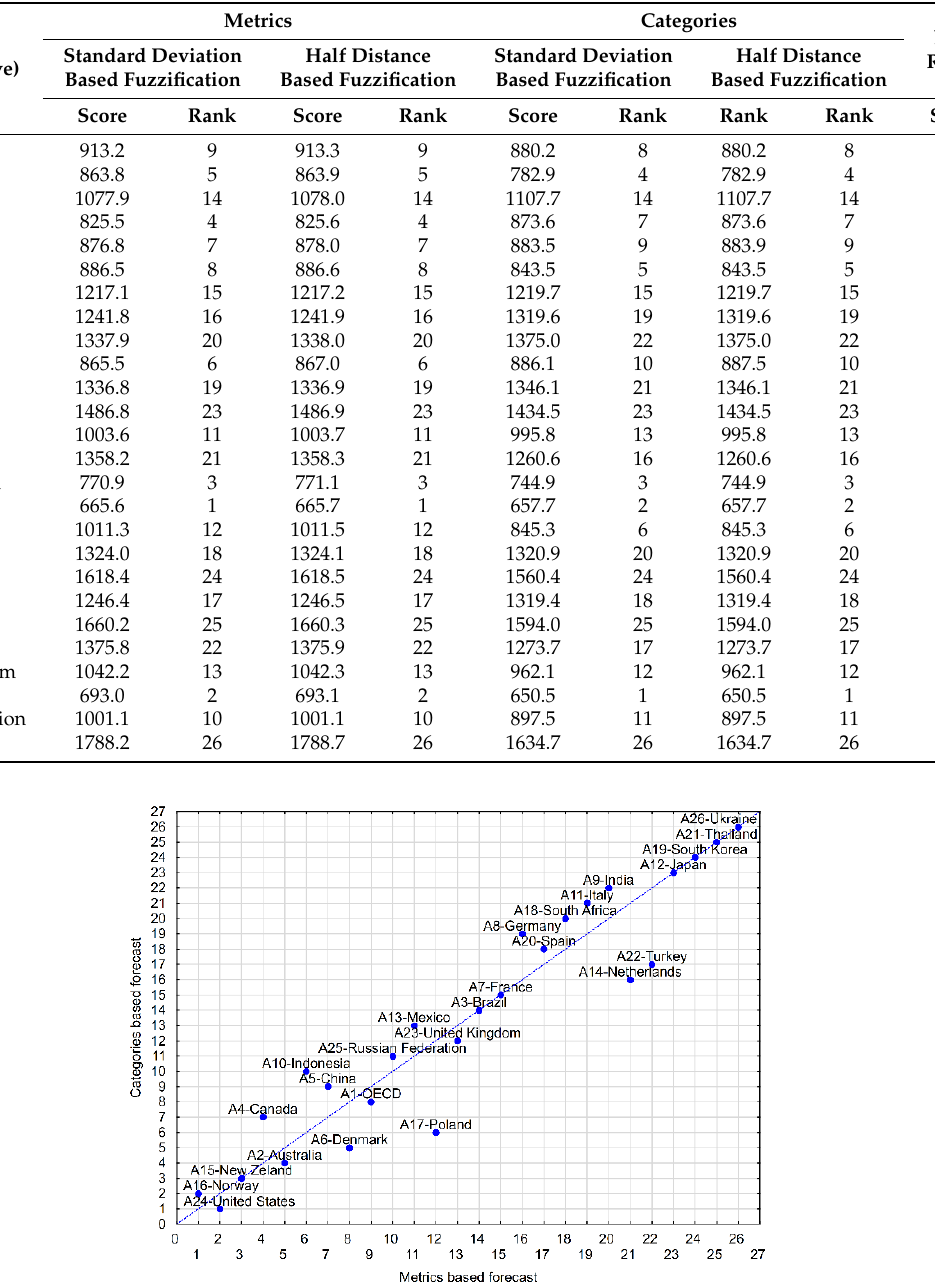
Table 5. IESRI rankings obtained using forecasted values of metrics and categories, as well as various fuzzification methods.